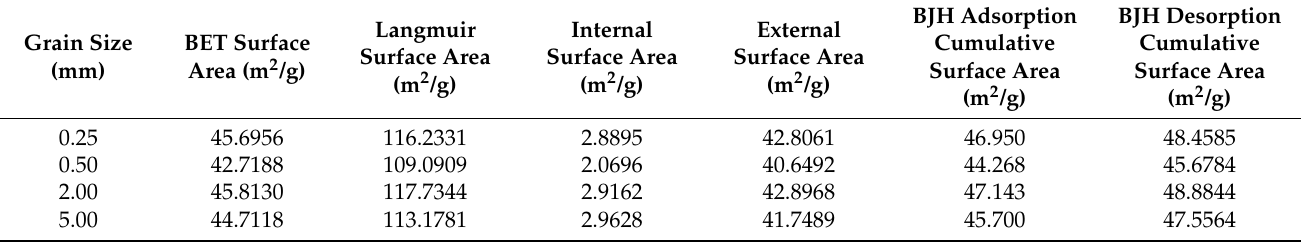
Table 4. The SSA of red clay with different particle